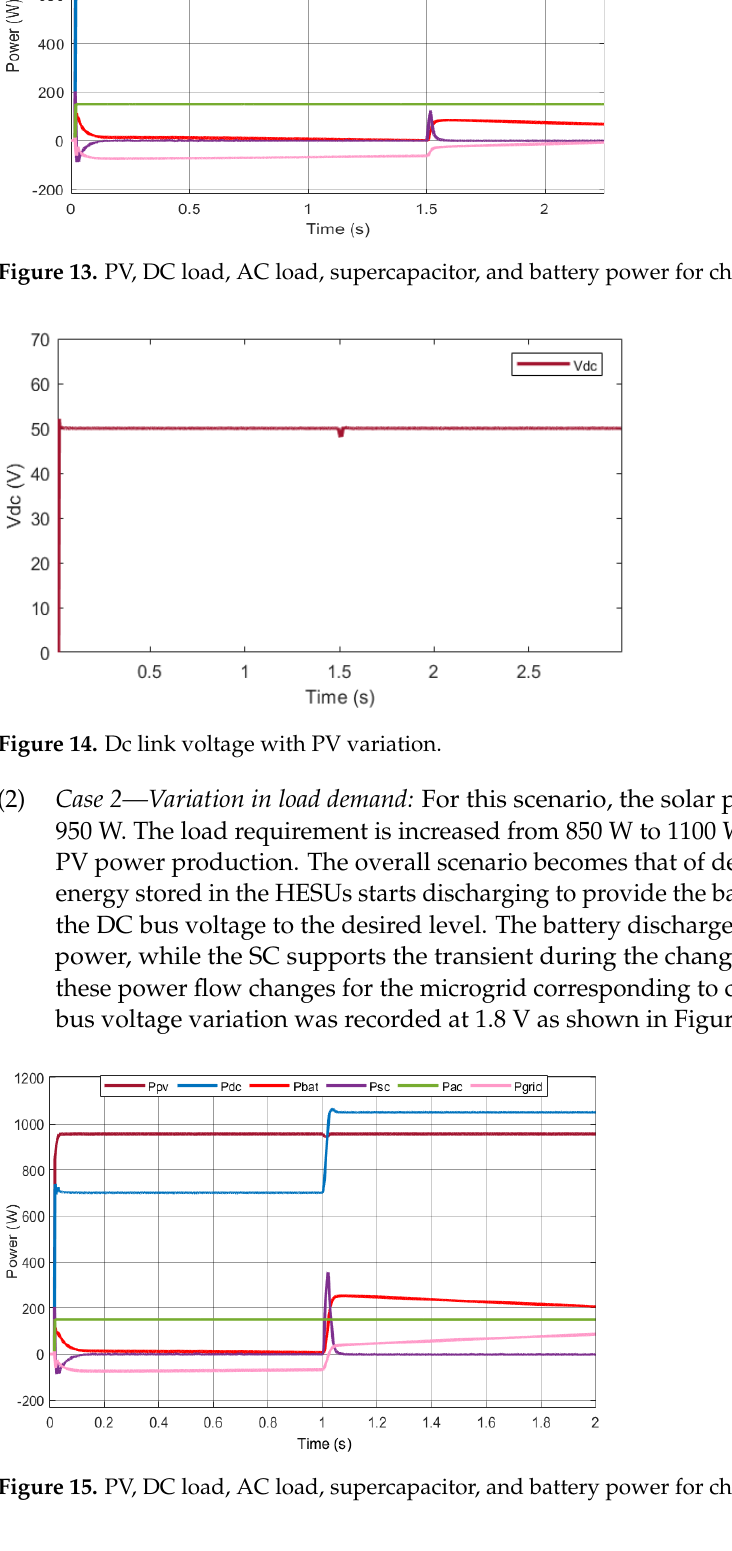
Figure 16. DC bus voltage with load change.